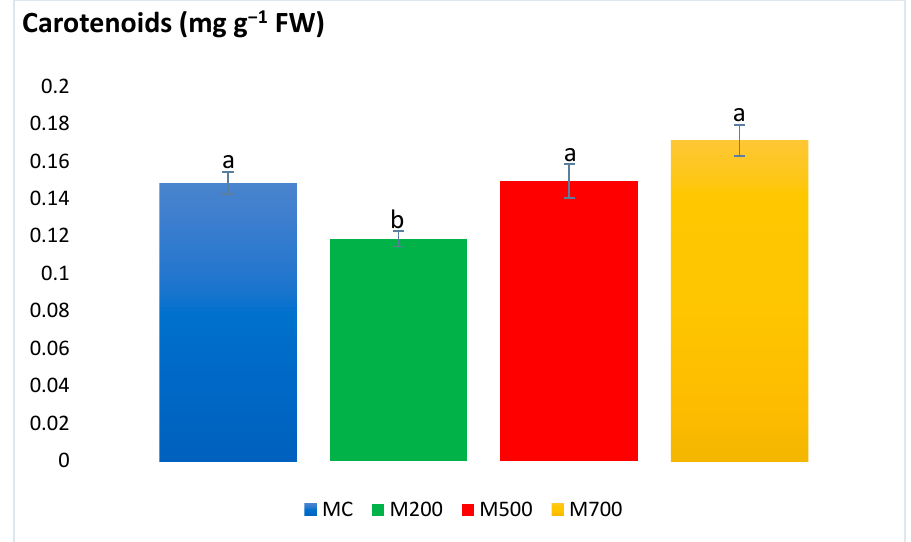
Figure 5. Concentration of carotenoids in the leaves of Mis-B cultivar cultivated in soils with gradient T.E. concentrations (MC, M200, M500, M700). Values are presented as mean ± SE. Different letters refer to significant differences between plants (Tukey HSD test, n = 6, p ≤ 0.05). Phenolic compounds (Figure 6) results showed no significant differences between samples. Values ranged between 25.07 ± 1.13 and 32.47 ± 2.50 mg gallic acid g − 1 FW in M200 and M700 plants, respectively.